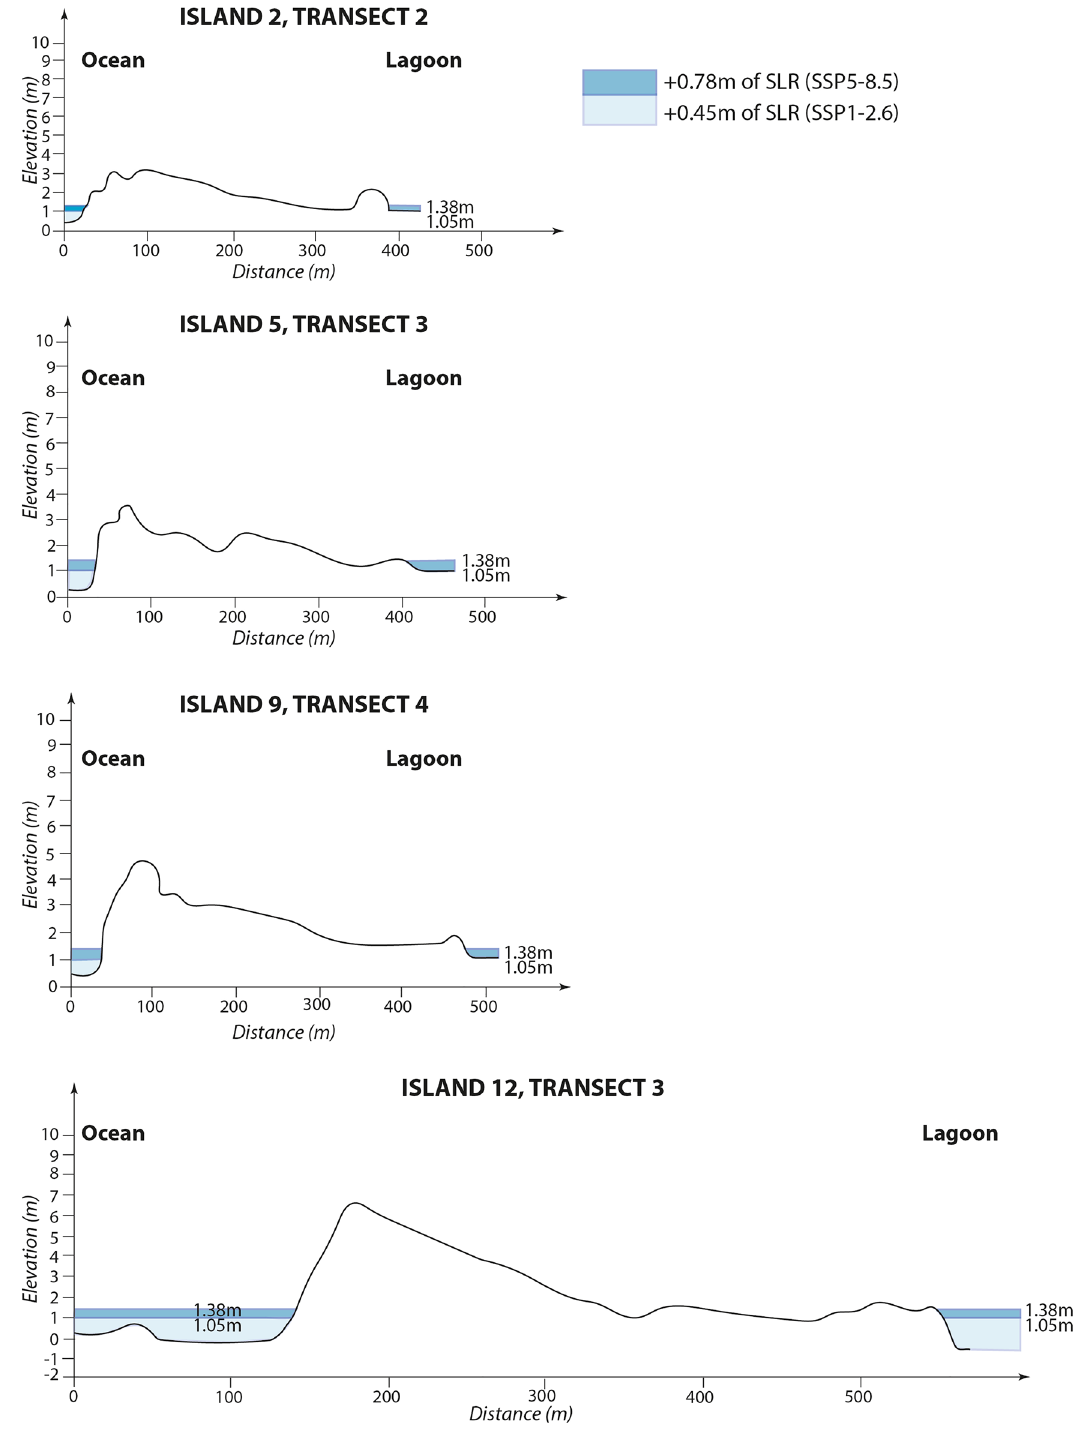
Figure 3. High-tide water levels under SSP1-2.6 and SSP5-8.5 climate scenarios for different island profiles around Rangiroa Atoll. This figure highlights major elevation and topography differences between islands, which result in high variations in their susceptibility to high-tide chronic flooding under SSP1-2.6 and SSP5- 8.5 climate scenarios: islands Nos. 2, 5 and 9 exhibit lagoon-side land loss, whereas island No. 12’s beach ridges prevent land loss. For details on Extreme Sea Levels, see Fig. 7 in “Materials and